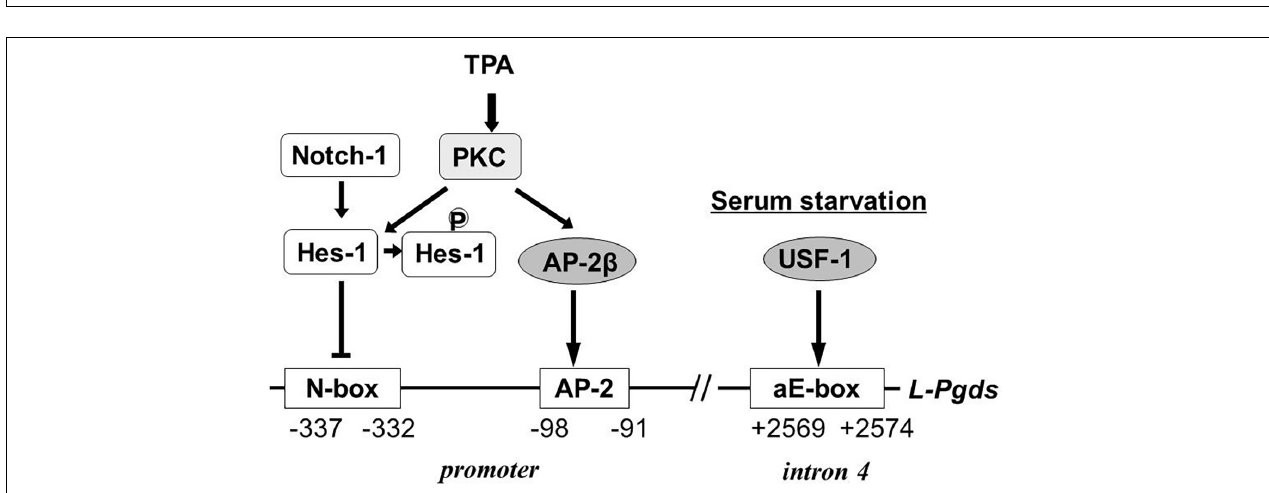
FIGURE 5 | Substrate-induced product-release mechanism for L-PGDS (Shimamoto et al., 2021).